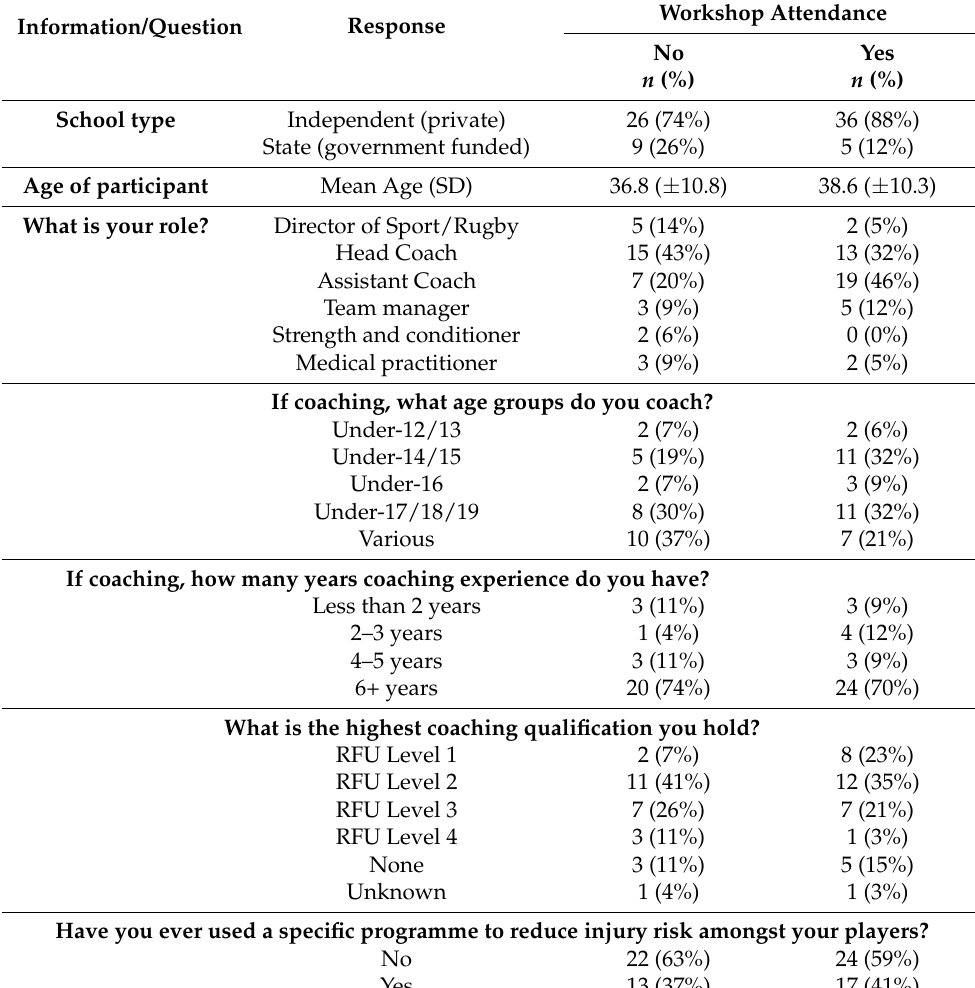
Table 1. Participant demographics by workshop